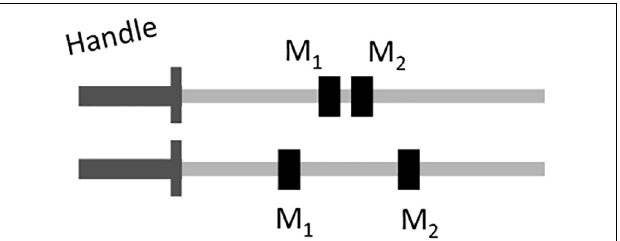
FIGURE 1 | Two rods with equal mass and static moment but with different principal moments of